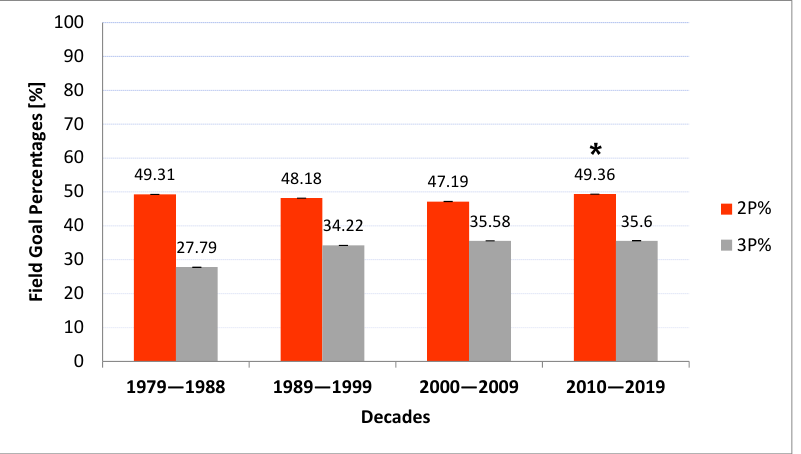
Figure 3. Three-point and two-point field goal percentages over four consecutive NBA decades. * Statistically significant compared with the previous decade with p < 0.05.